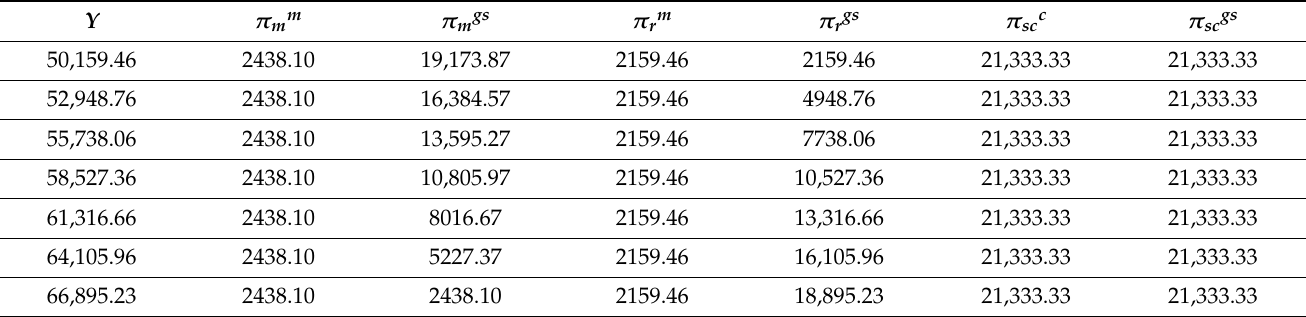
Table 3. Profit change with Y